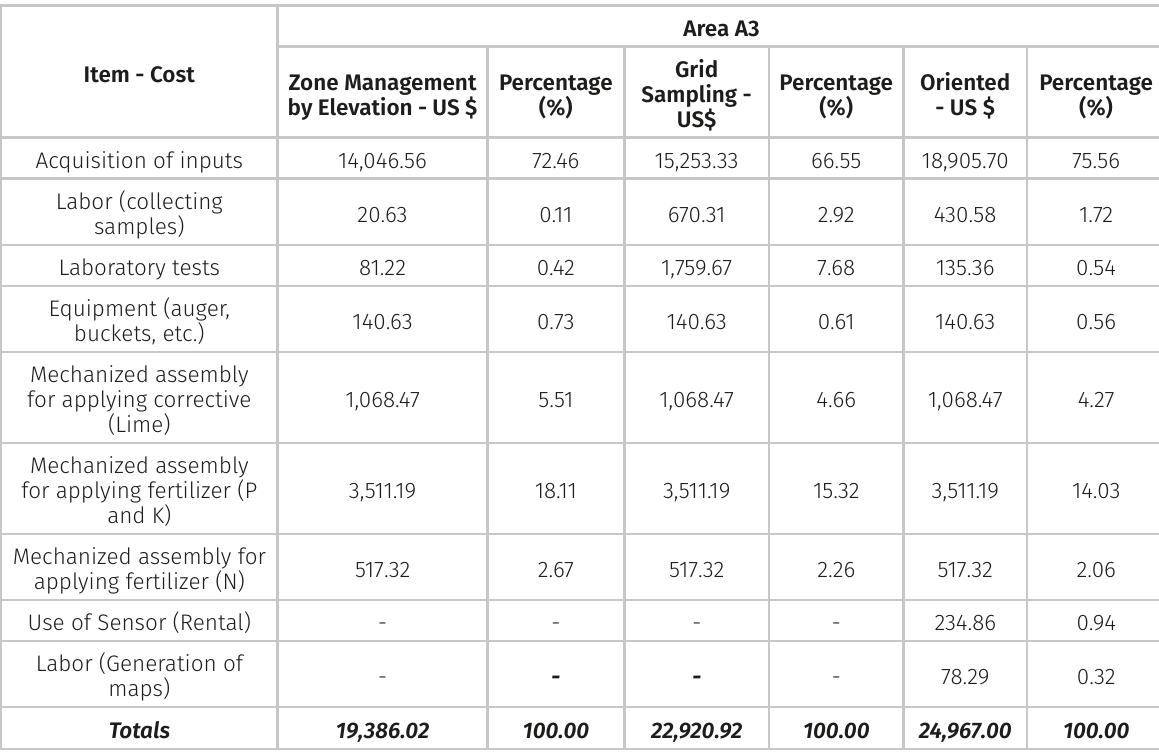
Table VII. Acquisition costs of raw materials, labor, laboratory analysis, equipment, machinery, sensor use and generation of maps for A3